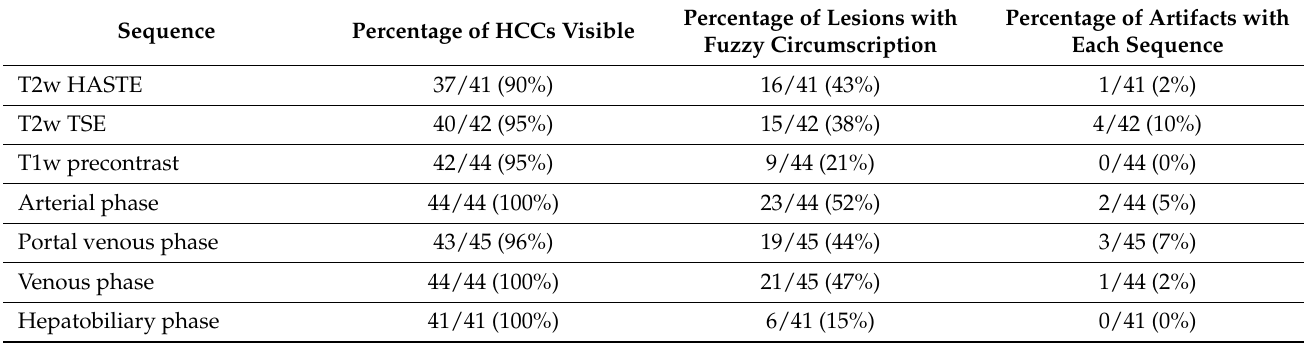
Table 3. Percentage of HCC visible on each available MRI